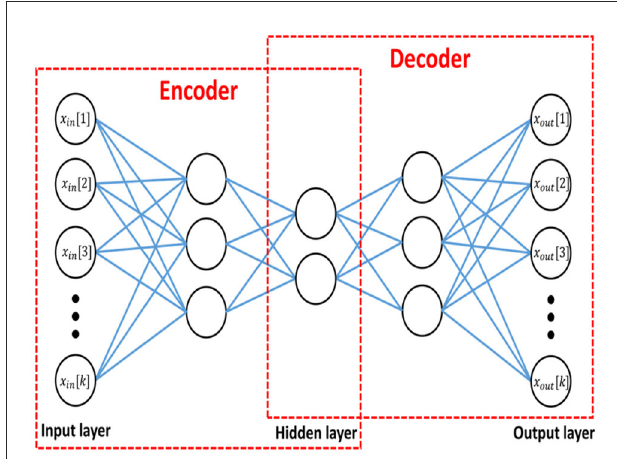
FIGURE3 The basic structure of an autoencoder.